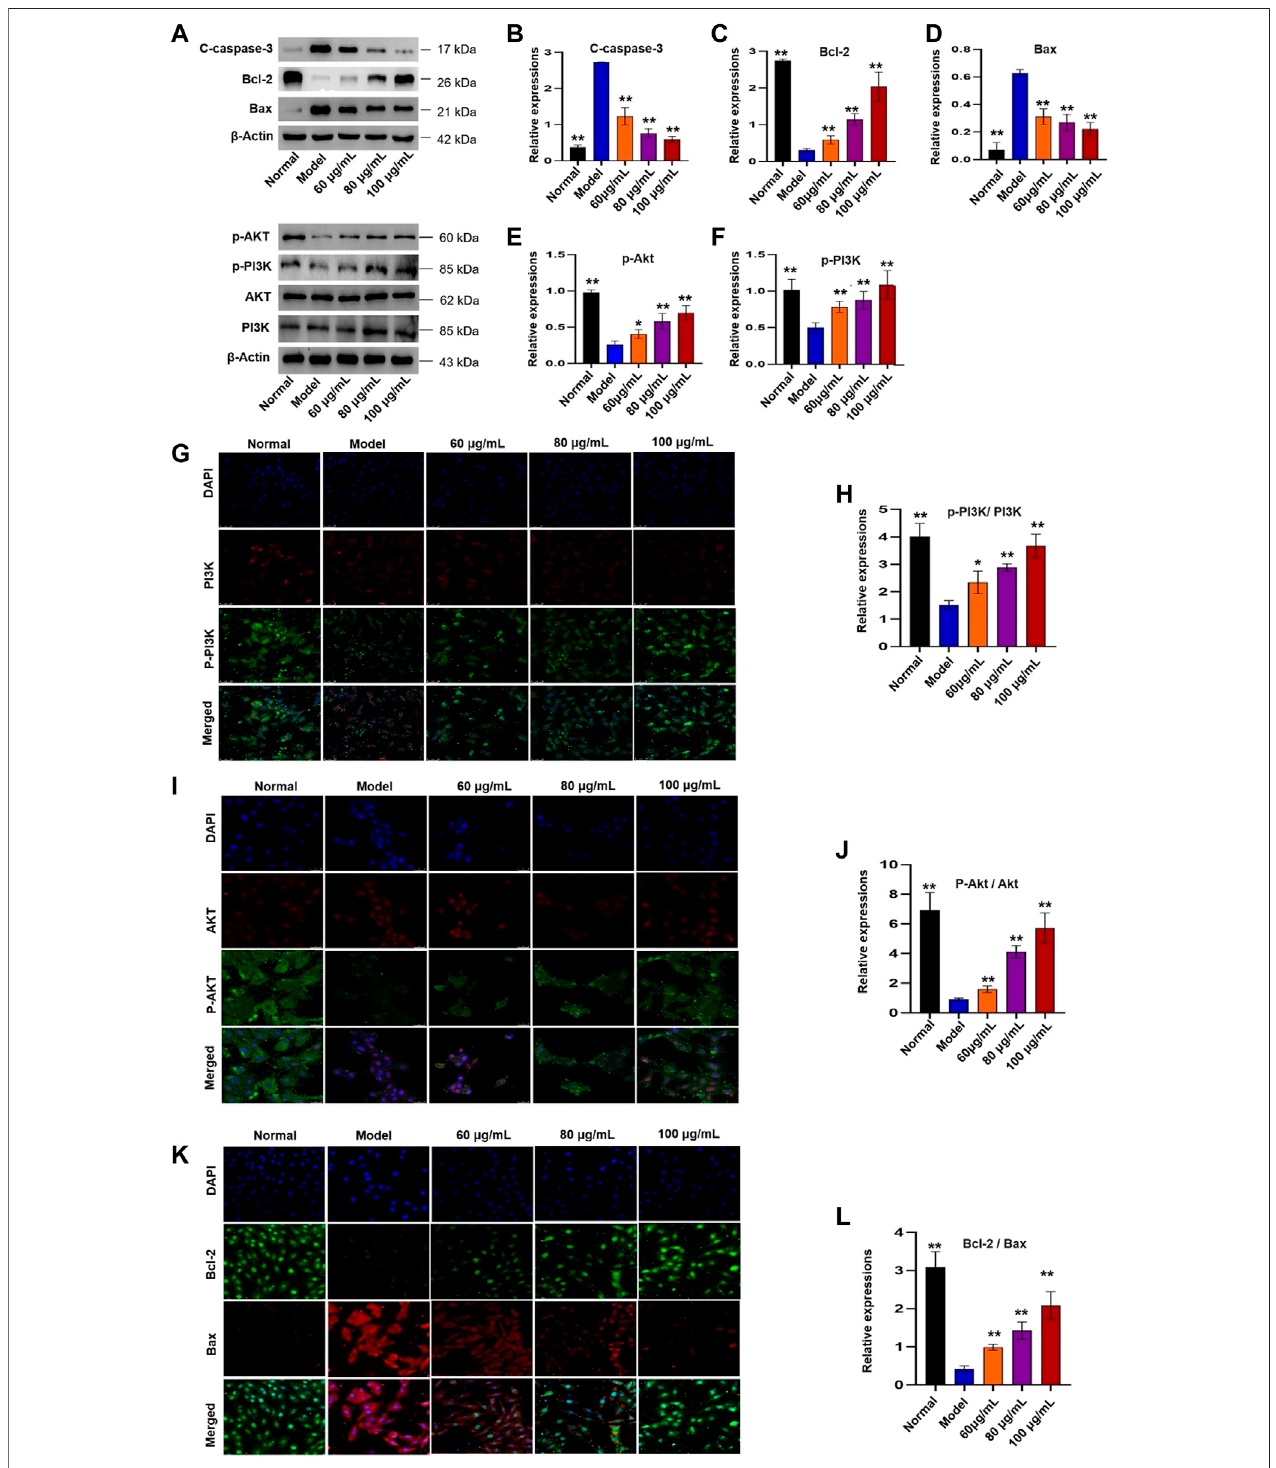
FIGURE10| EffectsofYTConPI3K/Aktsignalingpathway inH 2 O 2 -inducedH9c2cells. (A) WBimagesofC-caspase-3,Bcl-2,Bax,p-Akt,p-PI3K,AKTand PI3K proteinexpression. (B) AnalysisofC-caspase-3. (C) AnalysisofBcl-2. (D) AnalysisofBax. (E) Analysisofp-Akt. (F) Analysisofp-PI3K. (G) IFimagesofp-PI3KandPI3K. (H) Analysisofthep-PI3K/PI3Kratio. (I) IFimages ofp-Akt andAkt. (J) Analysisofthep-Akt/Akt ratio. (K) IFimagesofBcl-2and Bax. (L) AnalysisoftheBcl-2/Baxratio. Data were expressed as mean ± SD (n = 3), ** p < 0.05 and ** p < 0:01 vs model.